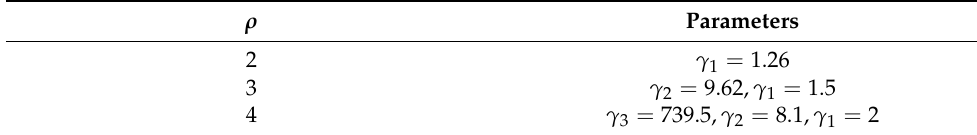
Table 1. Value of Parameter γ i − 1